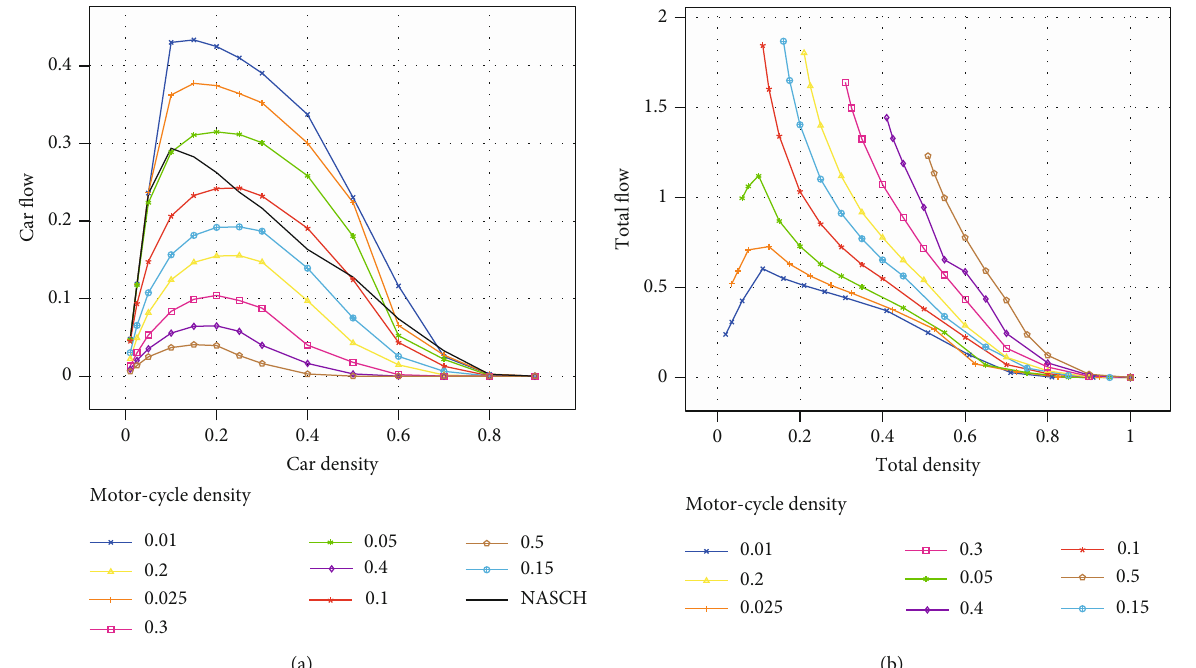
Figure 2: (a) Flow diagrams with sp = 0 : 25 and Ip = 0 : 25 for di ff erent motorcycle density. (b) Flow density diagrams with sp = 0 : 25 and Ip = 0 : 25 for di ff erent motorcycle density.